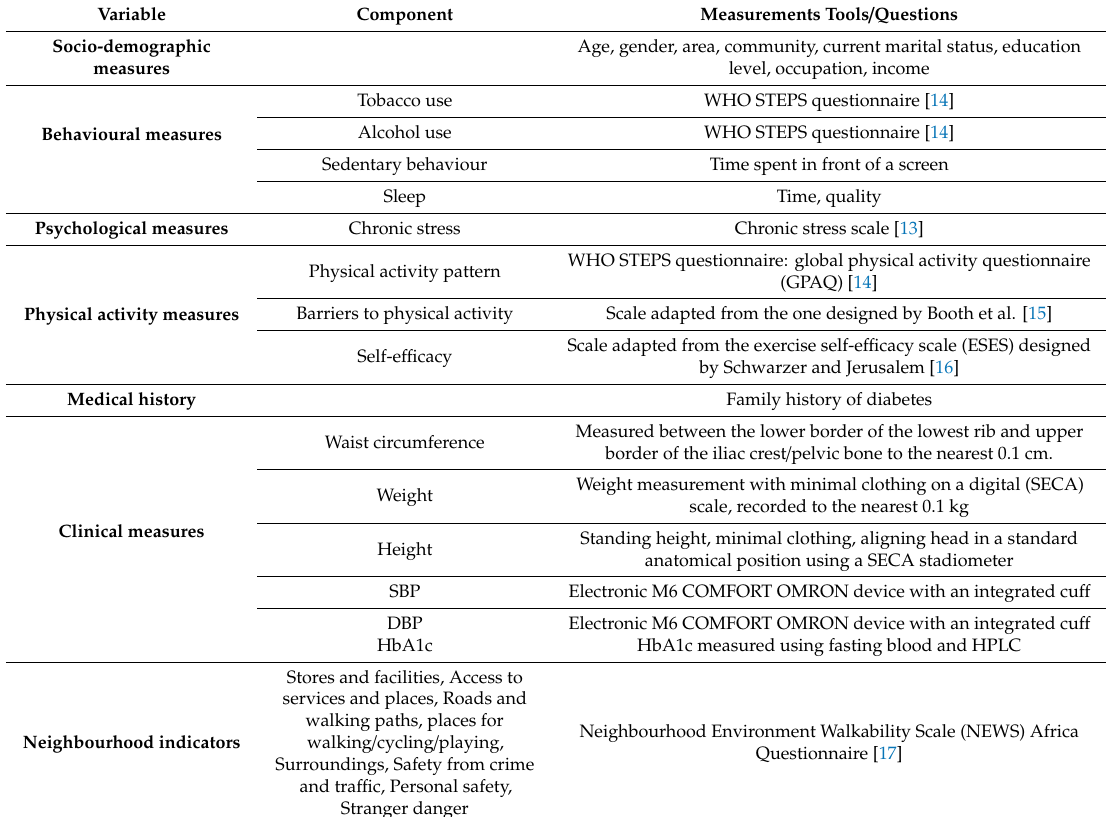
Table 1. Measurement domains, tools, and data collection for the South African Diabetes Prevention Programme’s pilot